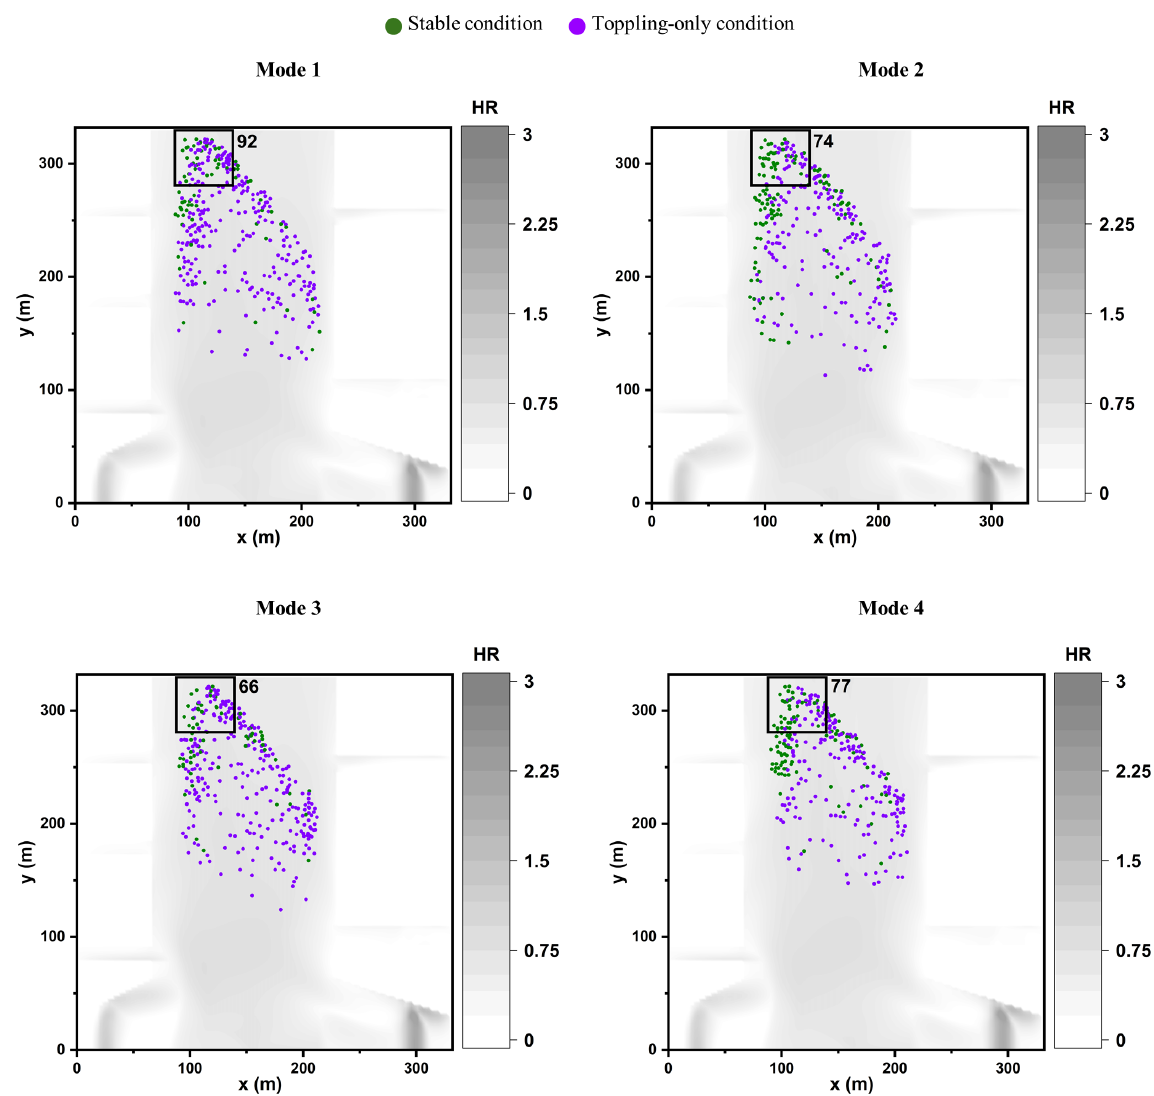
Figure 6. Spatial distribution of pedestrian agents, represented by coloured dots, predicted by the simulator under Mode 1 to Mode 4 at 6min after flooding. The grey colour represents the floodwater extent based on the flood HR quantity, and the square before the emergency exit represents an area of 50 × 50m 2 with a number printed alongside it representing the number of pedestrians in that